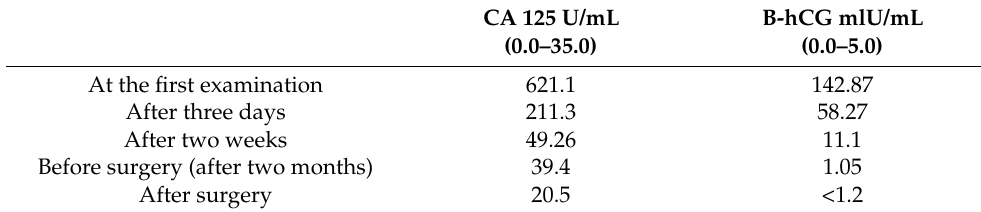
Table 1. CA 125 and B-hCG findings in the patient.